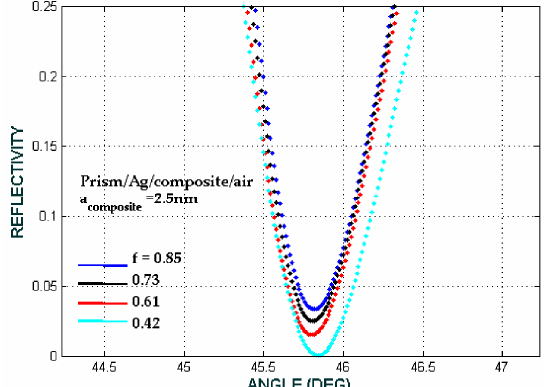
Figure 8. The ATR spectra with variations of f = ( b / a ) 3 with the SPR biosensor configuration prism/Ag/Fe 3 O 4 @Au/air ( a = 2.5 nm)